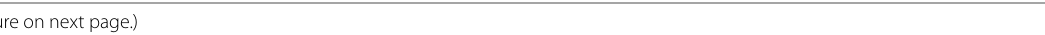
Fig. 4 Reduced hepatic fat accumulation in miR-100 mice under 16 weeks high fat diet feeding. a , b The level of liver cholesterol ( a ) was not significantly reduced, whereas triglycerides ( b ) were diminished in miR-100 animals. c , d Serum aspartate transaminase (AST) activity ( c ) was reduced in miR-100 overexpressing mice, whereas no difference was detectable in serum alanine transaminase (ALT) ( d ). e Representative pictures of cryo preserved liver sections (8 µm) stained for Oil Red O are shown. f The quantification of the Oil Red O positive areas was done using Image J software. Transgenic miR-100 mice displayed an improved glucose tolerance in glucose tolerance test (GTT) ( g , h ) as well as insulin sensitivity in insulin tolerance test (ITT) ( I , j ) compared to wildtype animals. (n 13–14 for all experiments) Data represent mean values with SEM. n.s. not = significant, *P < 0.05, **P < 0.01 and ***P < 0.001 vs. the